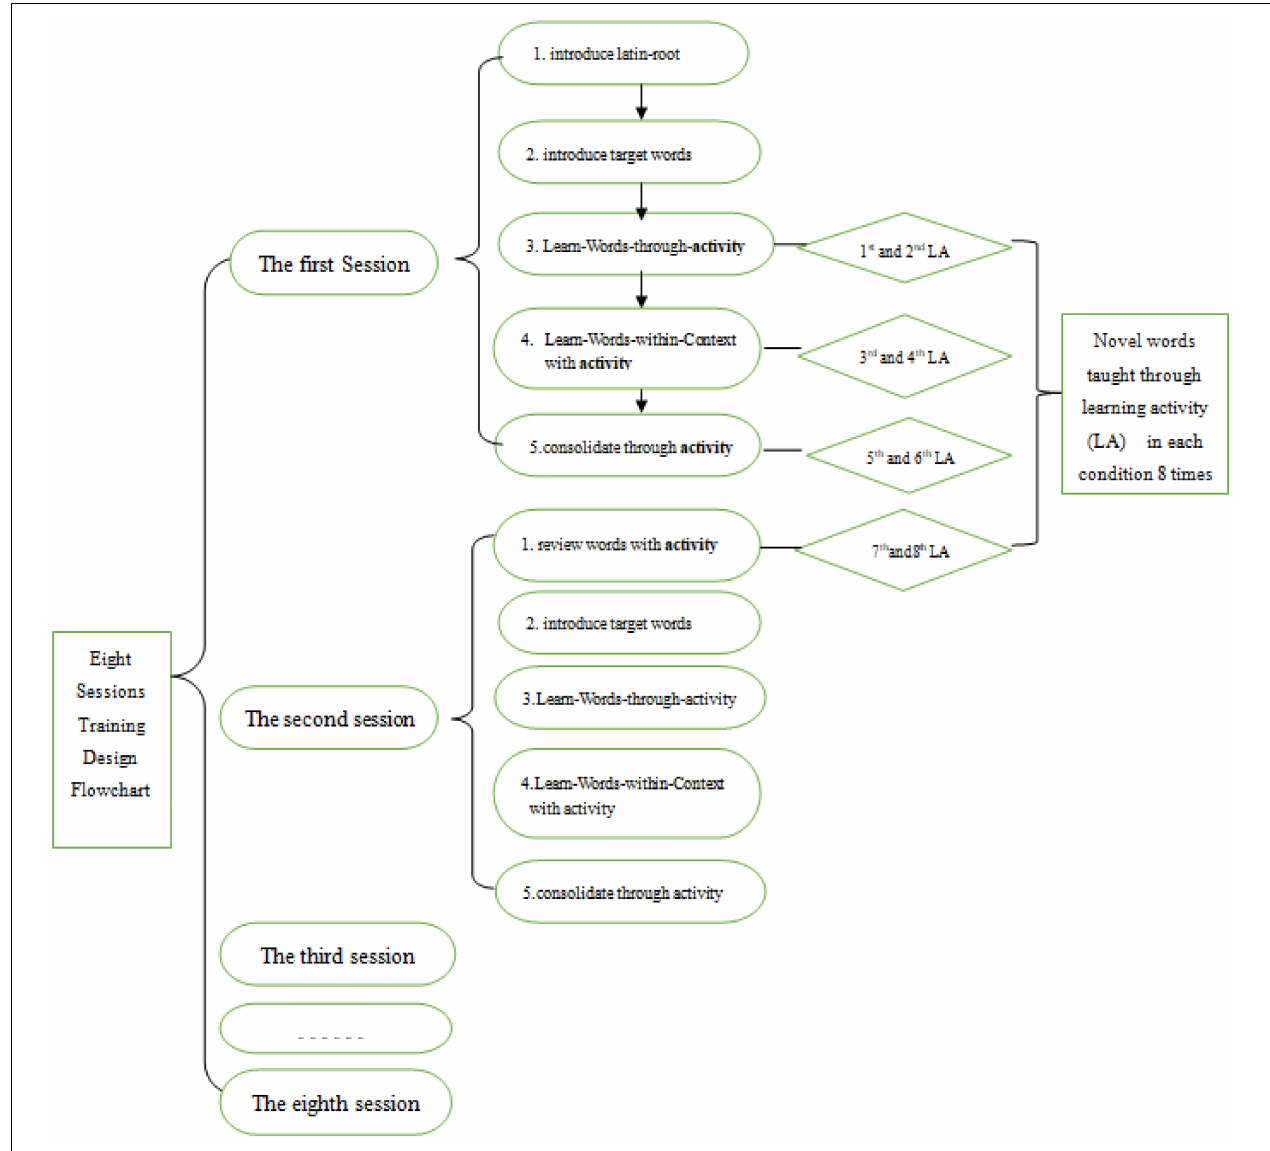
FIGURE 1 | Eight day training